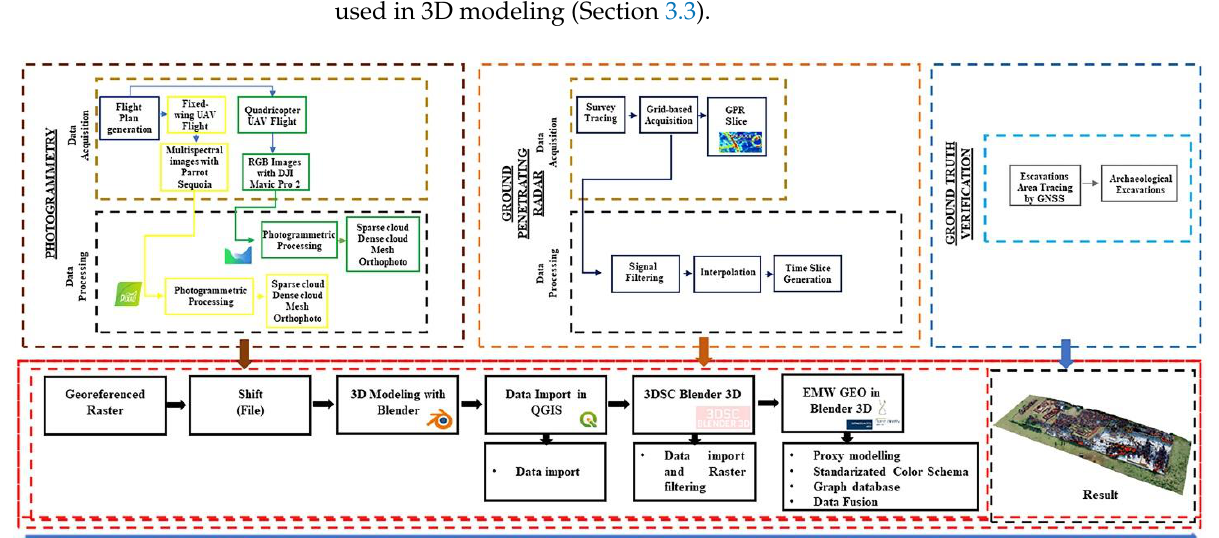
Figure 1. Graphic